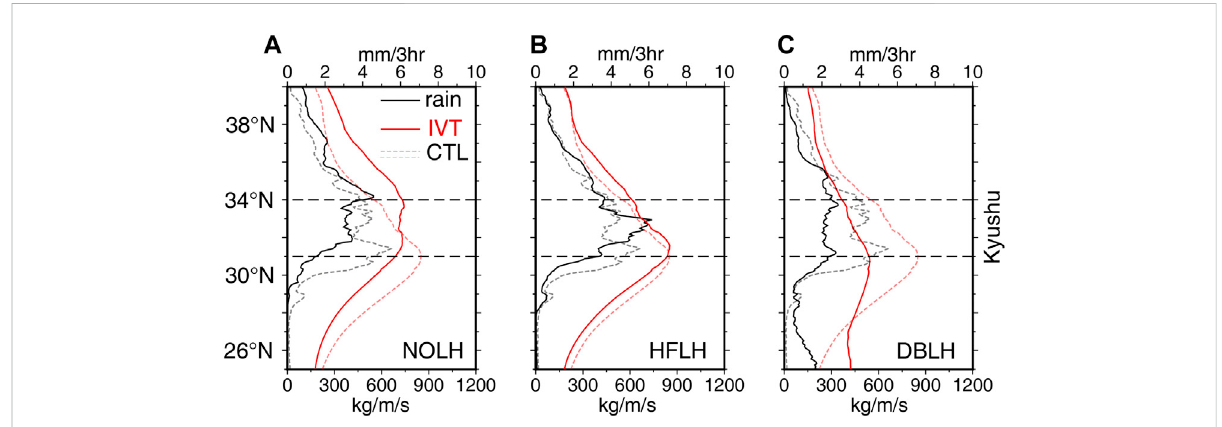
FIGURE 6 Meridional distributions of the mean moisture transport (IVT, red line) and precipitation (black line) along 130 ° E (averaged within 129 – 132 ° E) in each experiment, where the values in the CTL run are plotted in dashed lines.